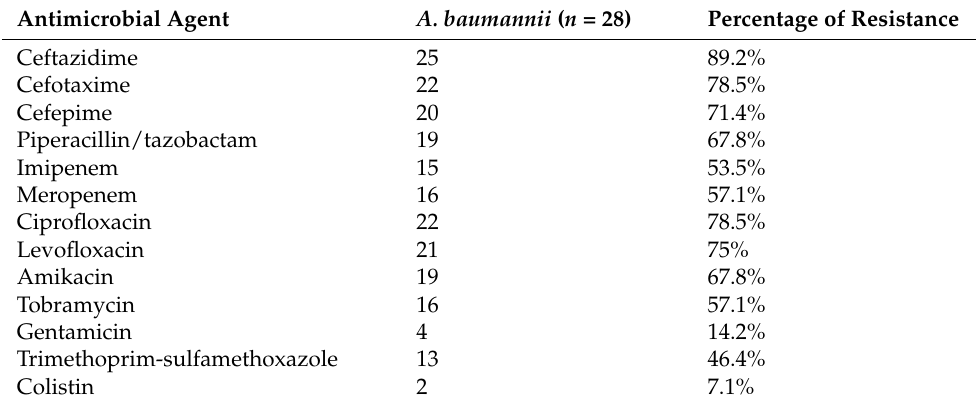
Table 2. The in vitro susceptibility of A. baumannii to common antimicrobial agents. Antimicrobial